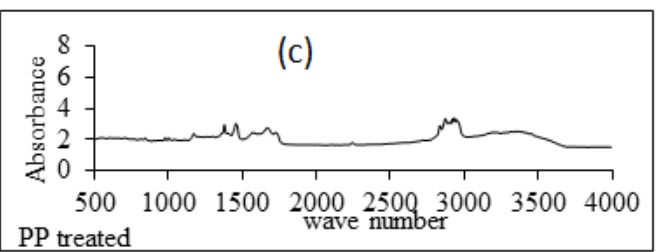
Figure 6. FTIR spectra for polypropylene. ( a ) pure, ( b ) grafted, ( c ) treated.